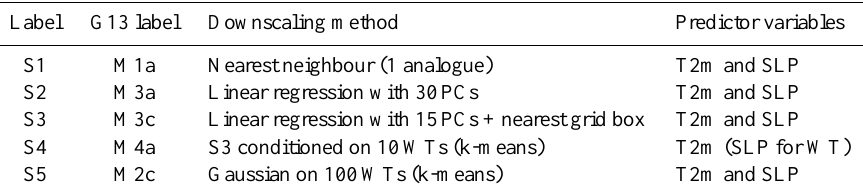
Table 1. Statistical downscaling methods and predictors. The second column is the label in Guti´errez et al. (2013), which provides further details of the different methods.